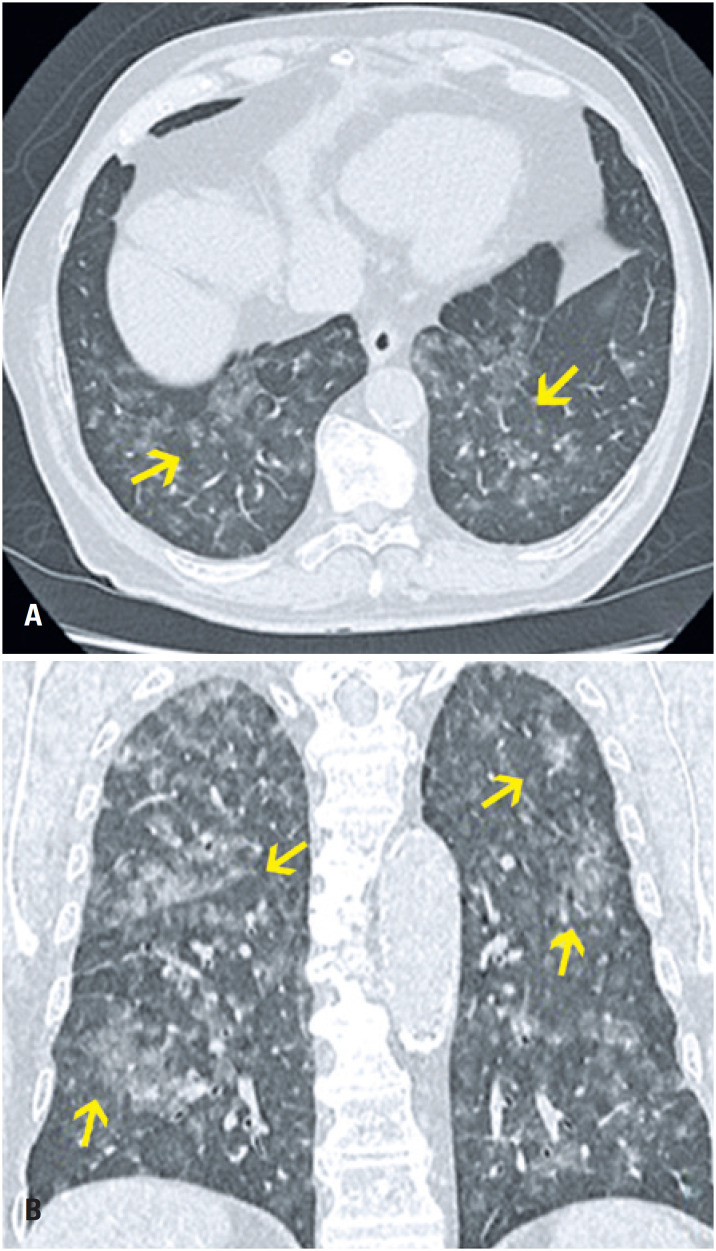
Homem, 85 anos, apresentando epistaxe e hematúria há 1 dia. Refere ter aumentado a dose do medicamento varfarina recentemente. Tomografia computadorizada (A) Axial (B) Reformatação coronal: numerosas opacidades em vidro fosco centrolobulares distribuídas por todos os lobos pulmonares